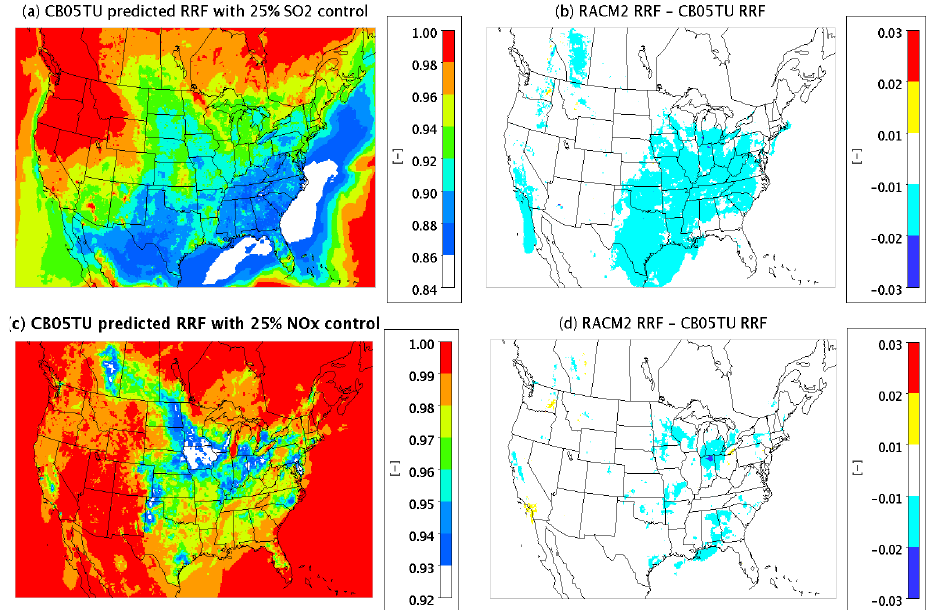
Fig. 13. (a) Relative Reduction Factors for PM 2 . 5 obtained with CB05TU due to 25% SO 2 control, (b) differences in Relative Reduction Factors for PM 2 . 5 between RACM2 and CB05TU due to 25% SO 2 control, (c) Relative Reduction Factors for PM 2 . 5 obtained with CB05TU due to 25% NO x control, (d) differences in Relative Reduction Factors for PM 2 . 5 between RACM2 and CB05TU due to 25% NO x